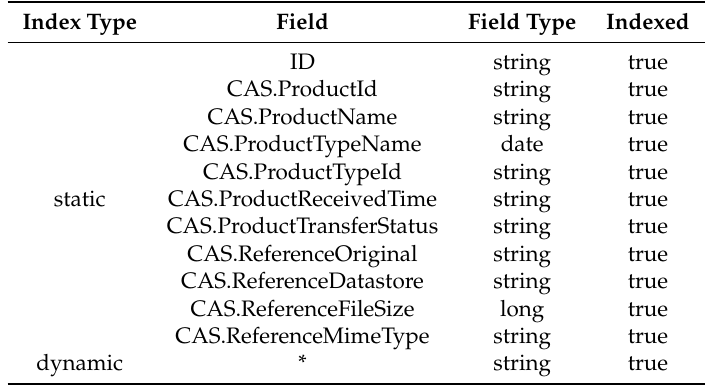
Table 2. The full-text index structure of multi-source remote sensing